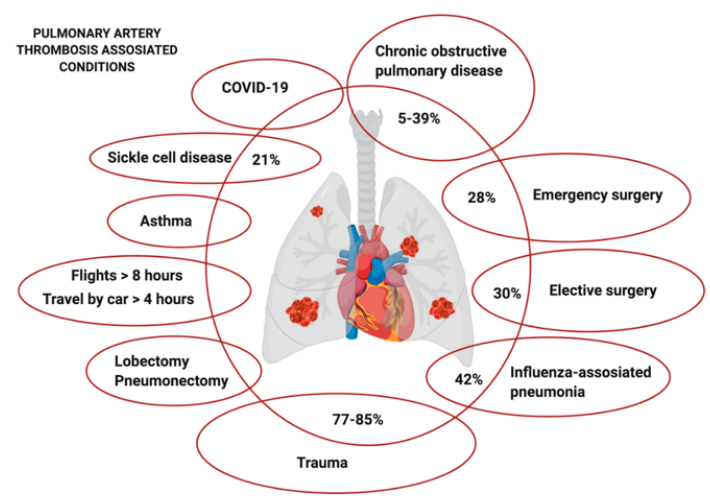
Figure 1. Diseases and conditions with high risk of pulmonary artery thrombosis. Percentages show patients with clots in the lungs and without clots in the deep